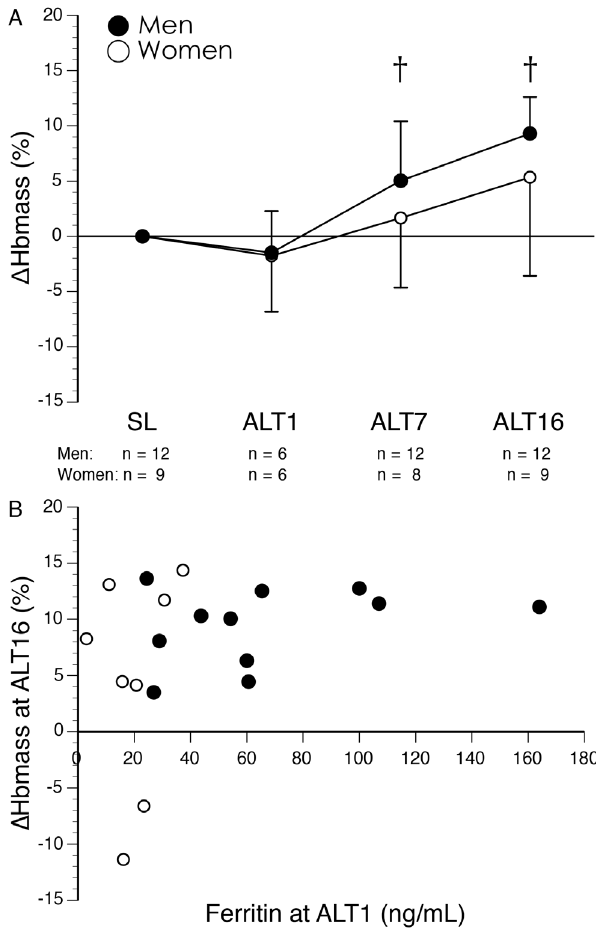
Figure 1. Hemoglobin mass in men and women during 16 days high altitude acclimatization. A) Time course of changes in absolute Hbmass. Data are presented as mean 6 SD, with the number of men and women tested at each time indicated below the x-axis. { Significantly different from sea level (p , 0.05; main effect of time). The percent changes were not significantly different between men and women (p . 0.05). B) Relationship between serum ferritin level upon arrival at high altitude and the percent change in absolute Hbmass following 16 days at high altitude. Two subjects had missing ferritin data at ALT1 and their Hbmass data were excluded from this graph. There was no correlation between initial ferritin level upon arrival at altitude and the percent change in absolute Hbmass during high altitude acclimatization (r=0.33; n=19; p=0.16).